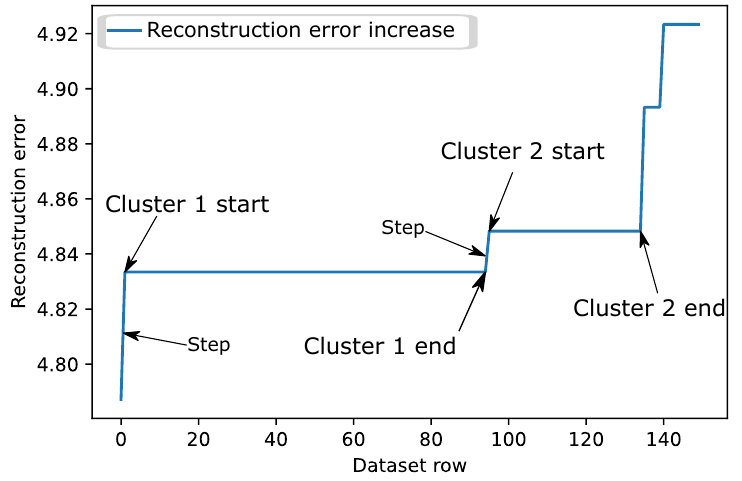
Figure 5. Visualization of clusters in a reconstruction error